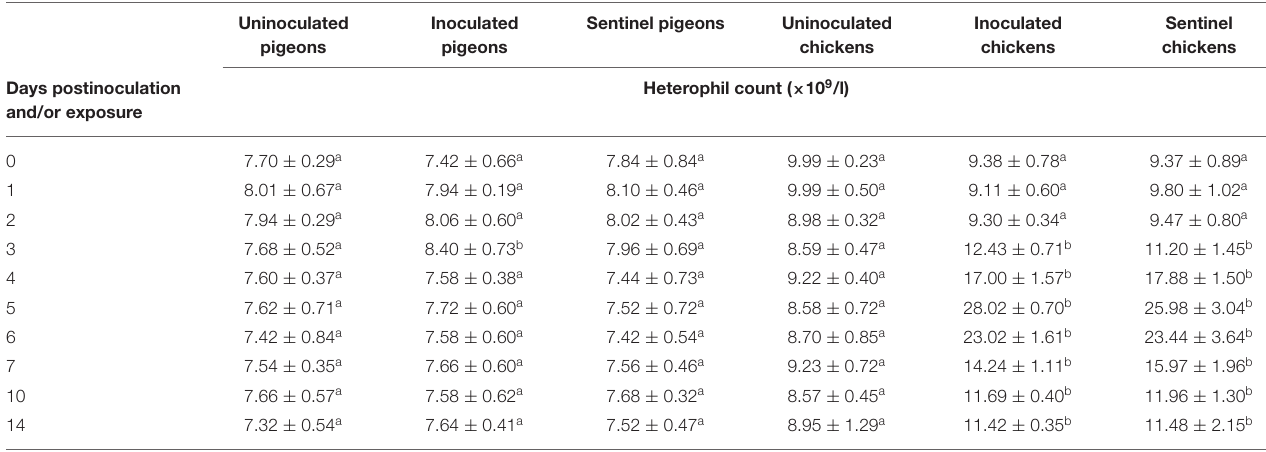
Uninoculated Inoculated Sentinel pigeons Uninoculated pigeons pigeons